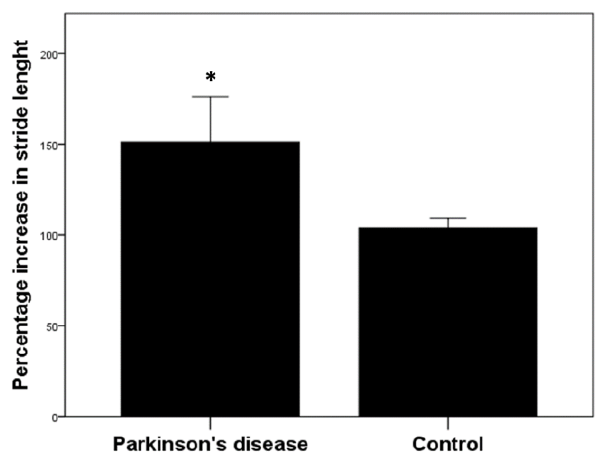
Figure 4. Comparison of percentage increase in stride length between two groups. Percentage change in stride length of plantar stimulation respect to basal (before plantar stimulation) level. * p < 0.05 Mann–Whitney test.